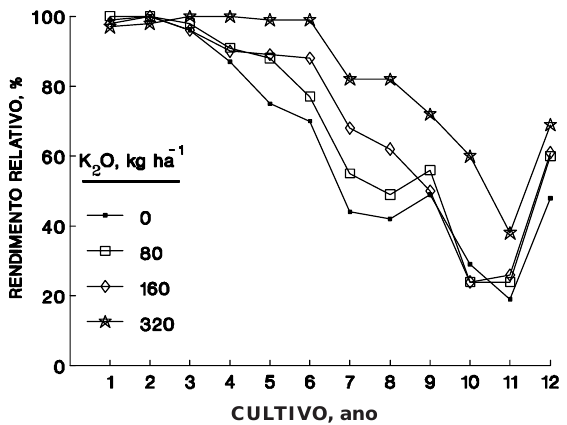
Figura 1. Efeito residual da adubação potássica no rendimento relativo de soja ao longo de doze anos de cultivo. Média de três